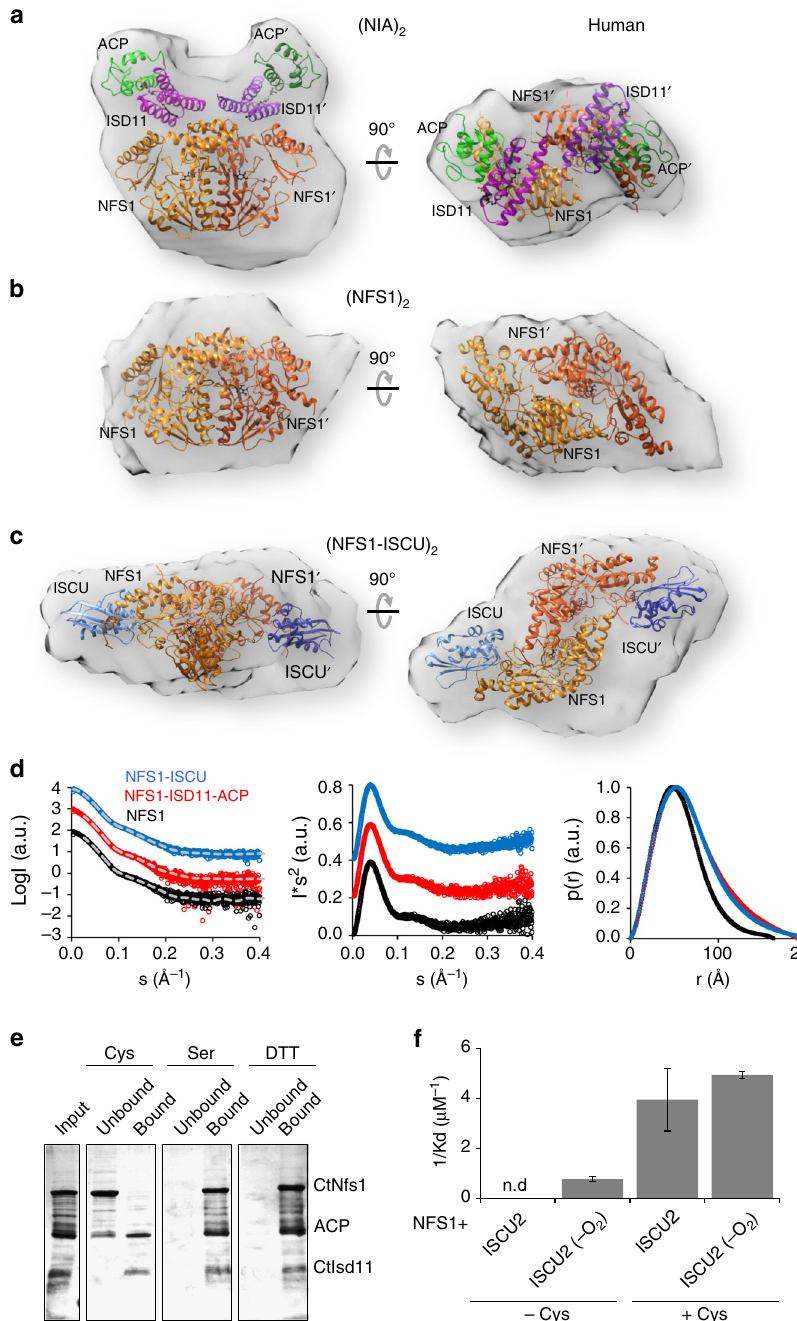
Fig. 5 SAXS shapes and stability of human ISC complexes. a – c , Small angle X-ray scattering (SAXS) analyses were performed with the indicated ISC complexes. Crystal structures of the (NIA) 2 complex a , the NFS1 dimer part alone b or the NFS1-ISCU part of (NIAU) 2 c were fi tted into the determined SAXS densities. d Scattering curves with respective fi ts in gray (left) and Kratky plots (middle) for above complexes show no signs of aggregation and suggest a homogeneous solution of the respective complexes. The pair distribution plots (right) show the respective D max values. e Cysteine induces dissociation of CtNfs1 from CtIsd11-ACP. The CtNfs1-CtIsd11-His 6 -ACP complex was incubated with cysteine (Cys), serine (Ser) or dithiothreitol (DTT) under anaerobic conditions and bound to Ni-NTA resin. Proteins eluting from the column (unbound) and resin-bound material (after elution with imidazole) was analyzed by PAGE and Coomassie staining. f Equilibrium constants for human NFS1 interaction with ISCU2 were measured by microscale thermophoresis in the absence (left) or presence (right) of cysteine. In part f ISCU was used either aerobically or anaerobically (-O 2 ). The error bars indicate the SD of the sigmoidal fi t (see Supplementary Fig. 5e for original data) of three biological